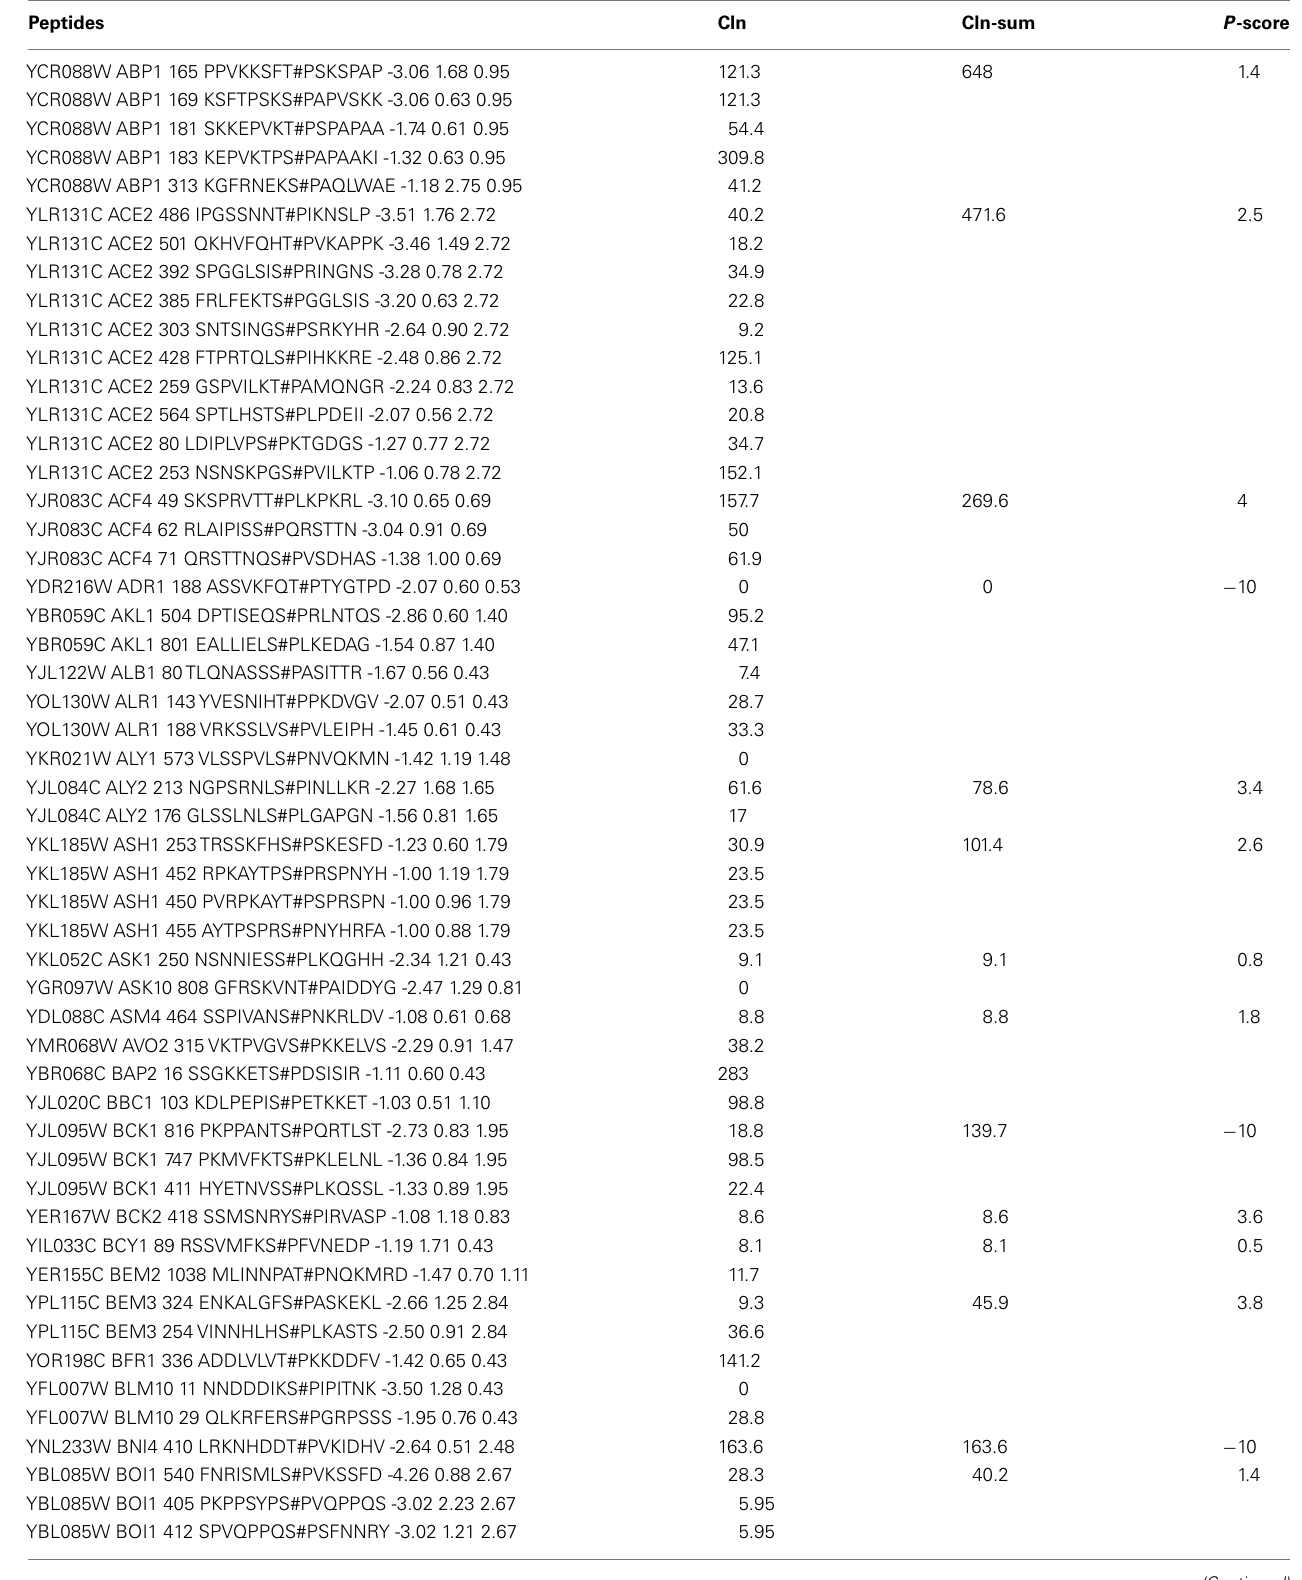
TableA2 | Phosphorylation of Cdk1